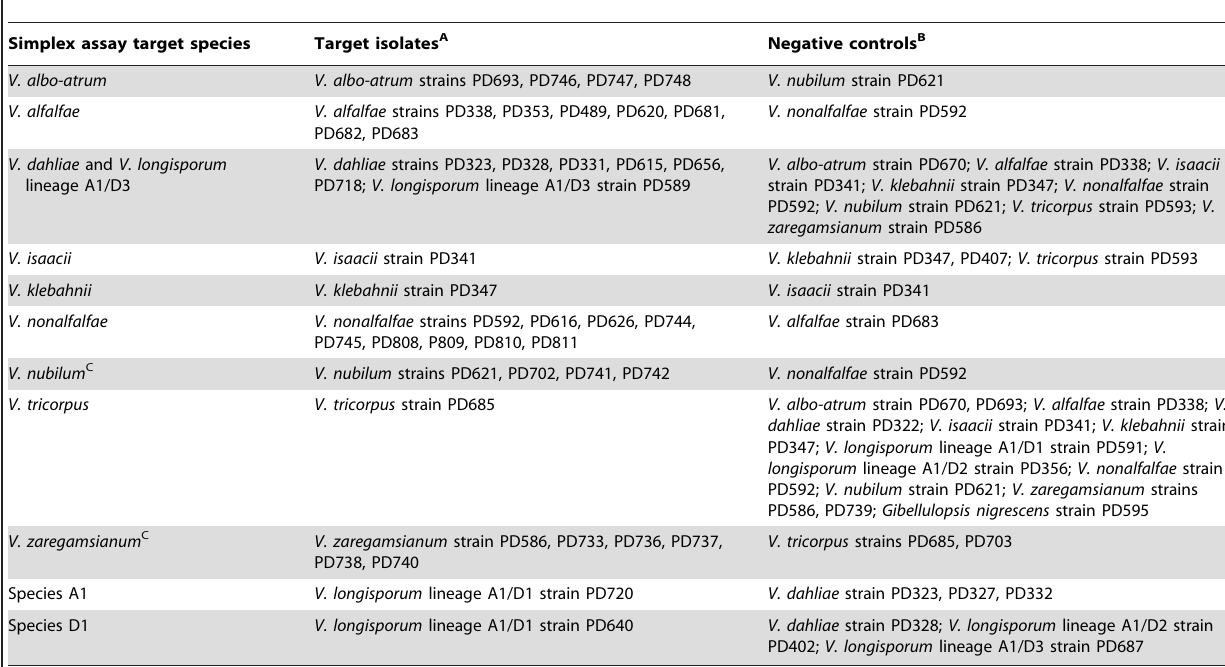
Table 3. Isolates used in the validation of the Verticillium simplex PCR assays.